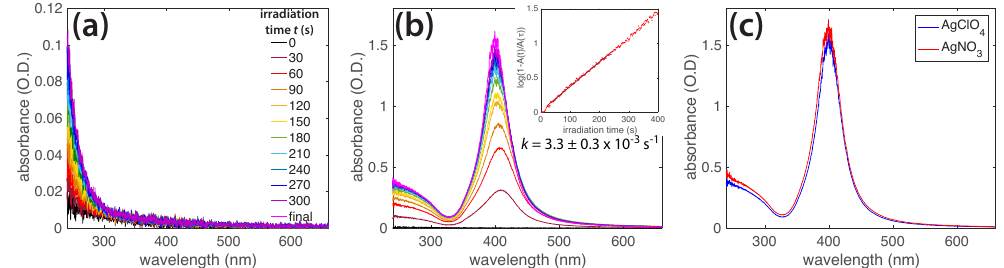
Figure 7. ( a ) Absorption spectra of AgClO in water irradiated for 600 s, showing no silver nanoparticle 4 (AgNP) formation in the absence of ammonia; ( b ) Absorbance peak of AgNPs from AgClO in NH (1 mM) as it grew during irradiation; ( c ) Absorbance spectra of AgNPs formed from irradiating 3 AgClO (red) and AgNO (blue) in 1 mM NH 4 3 3